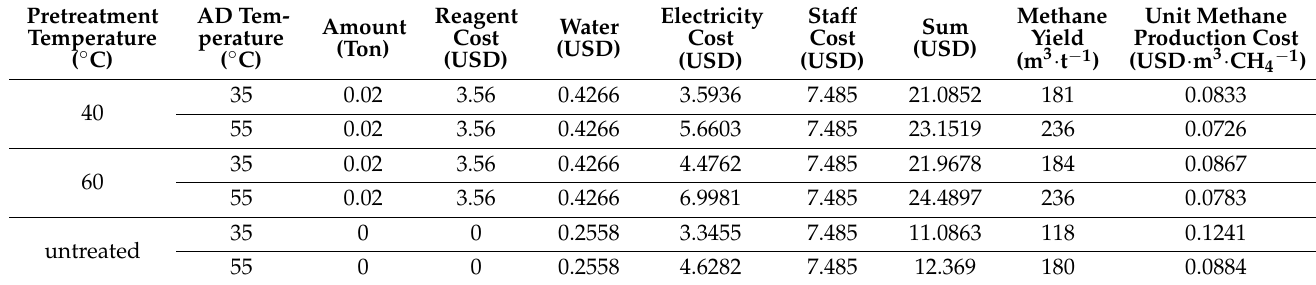
Table 7. Economic analysis of different